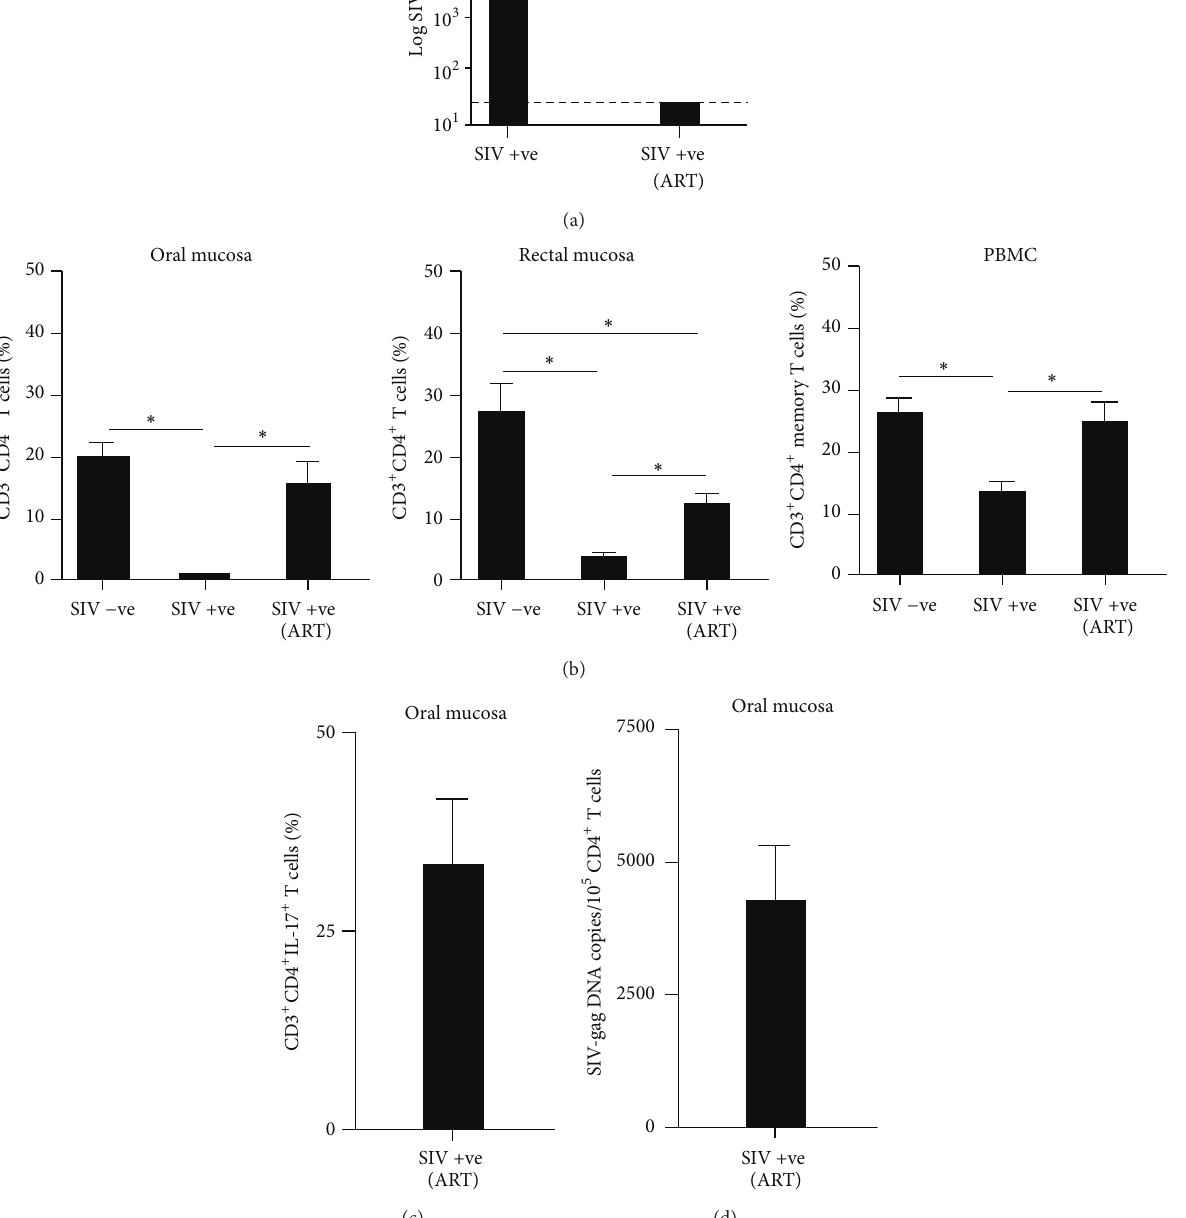
Figure 3: CD4 + T cells are significantly depleted in the oral mucosa during chronic SIV infection but repopulate during ART. (a) Plasma viral loads (limit of detection is 30 copies/mL of plasma) in untreated and treated animals. (b) Proportions of total CD4 + T cells in the oral and rectal mucosa and central memory CD4 + T cell subsets in peripheral blood during chronic SIV infection and ART. (c) Proportions of CD4 + IL-17 + T cells in the oral mucosa during ART. (d) Level of SIV infection in sorted CD4 + T cells from the oral mucosa during